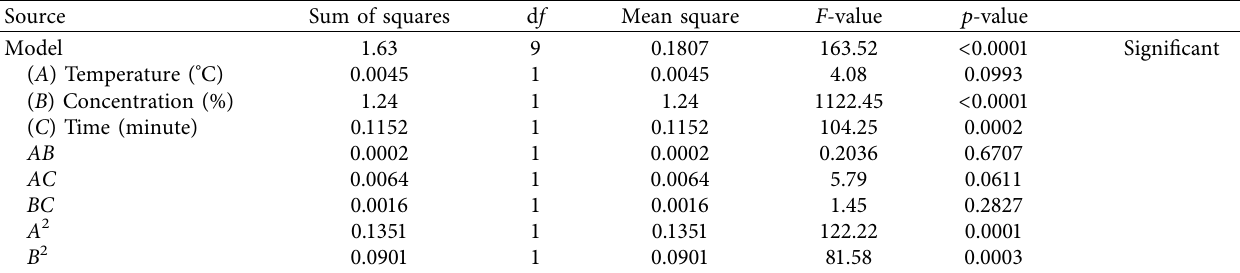
Figure 2: Factor interaction effect on 3D surface graph absorbency. Table 3: Analysis of variance (ANOVA) for weight loss of enzyme-treated dyed